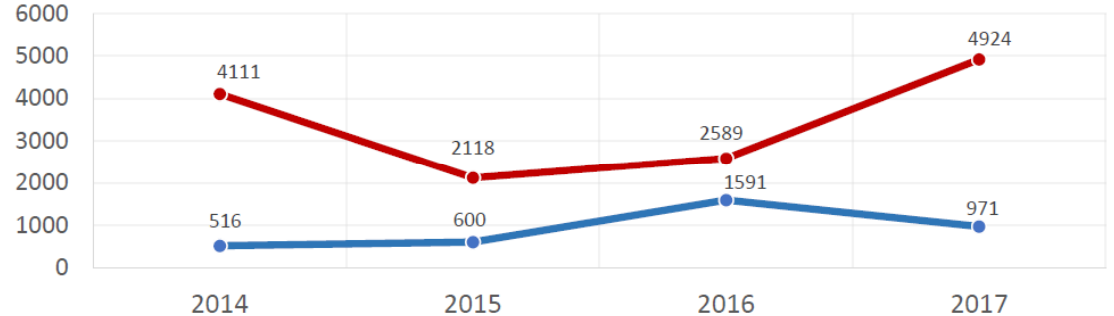
Figure 14: Outflow shares of profit from the Czech Republic in the construction sector (in millions of CZK), (source: Annual report of EUROVIA CS, SKANSKA, STRABAG 2014-2018, data processed by the authors,